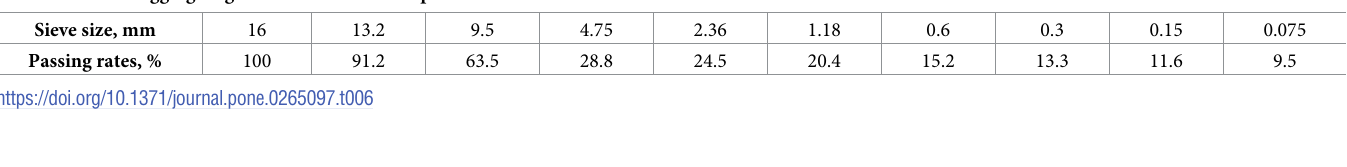
Table 6. Mineral aggregate gradation of SMA-13 asphalt